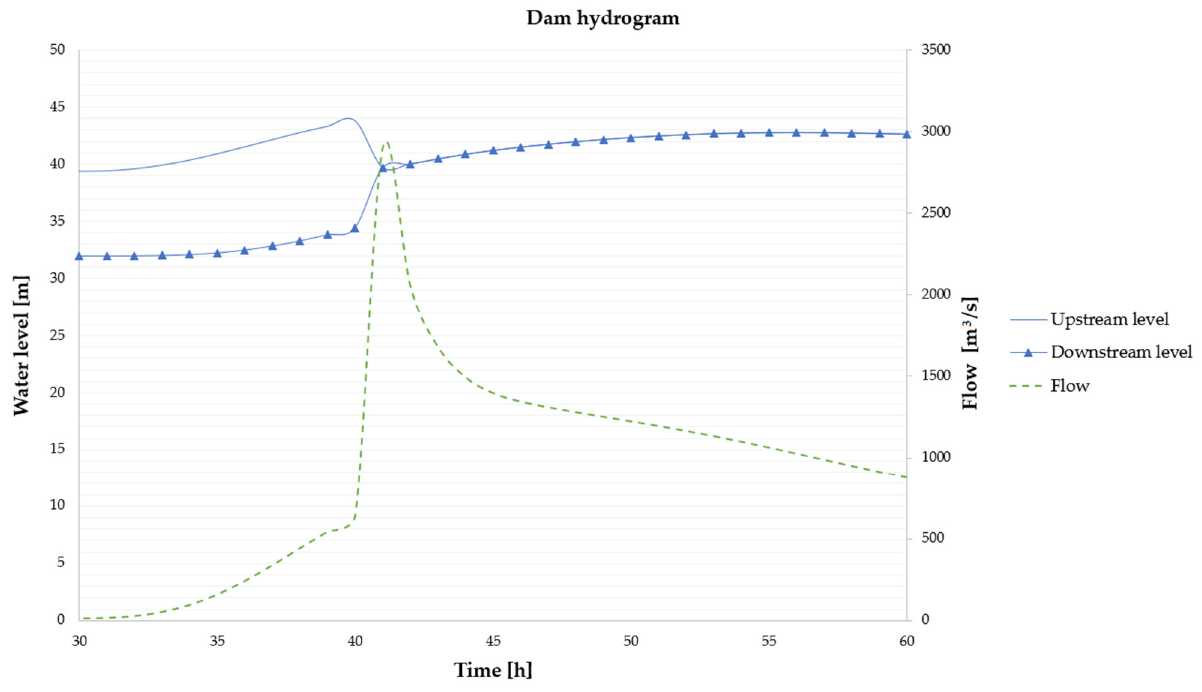
Figure 9. Failure hydrograph scenario A.